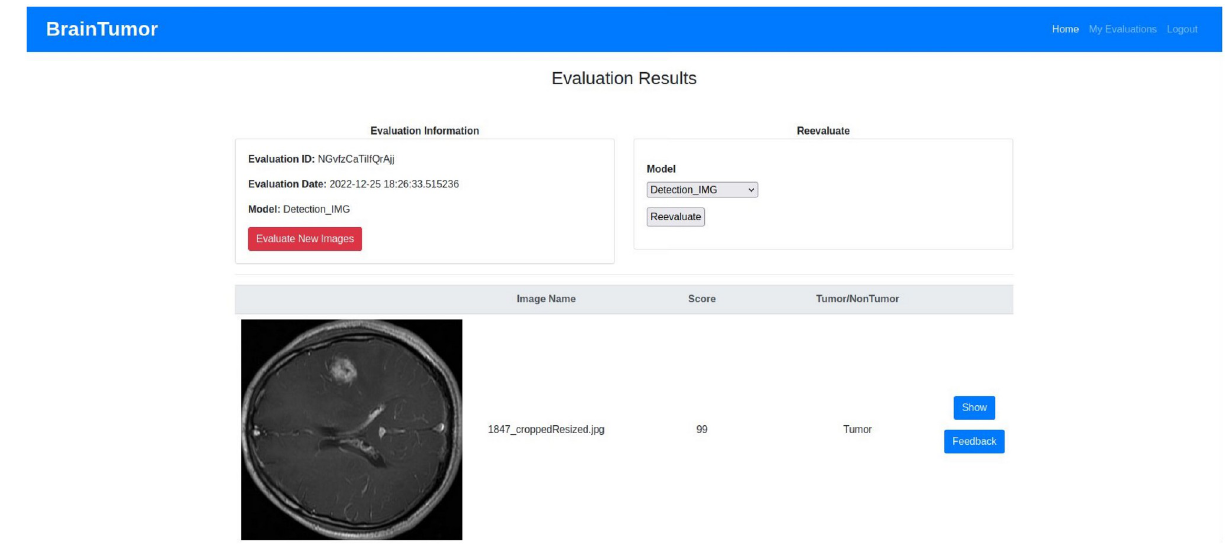
Fig 13. Tumor detection evaluation results